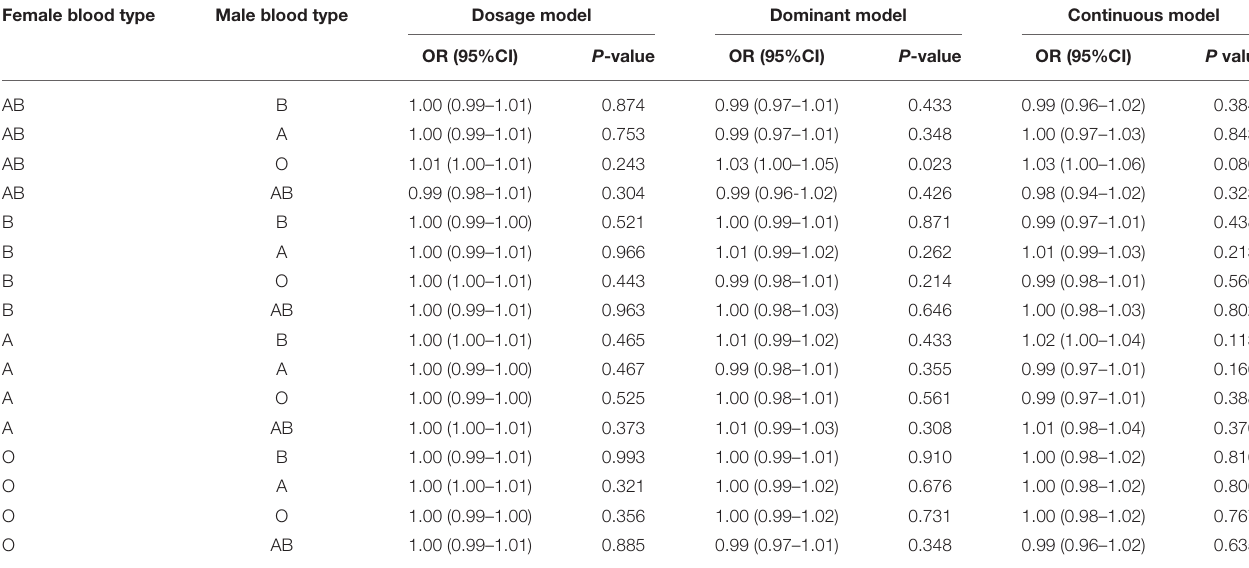
TABLE 2 | Multivariate logistic regression analyses between the history of spontaneous miscarriage and parental blood type combinations.